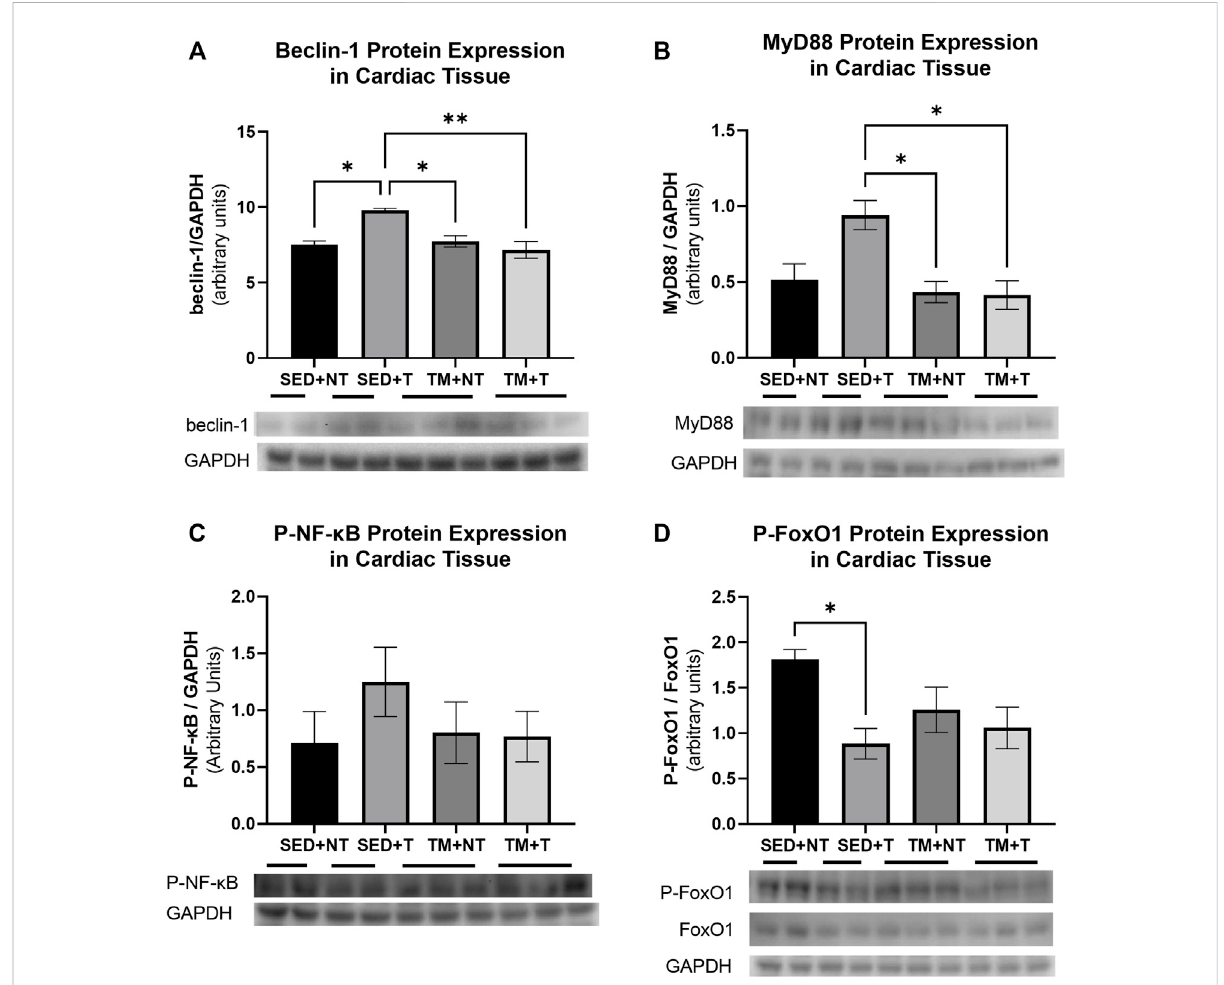
FIGURE 5 Cardiac expression of autophagy protein Beclin1 (A) ; in fl ammatory markers MyD88 (B) and p-NF-kB (C) ; and atrophy protein p-FOXO1 (D) . Tumor bearing results in increased autophagy (belcin-1), in fl ammation (MyD88), and atrophy and metabolism (p-FOXO1). Preconditioning